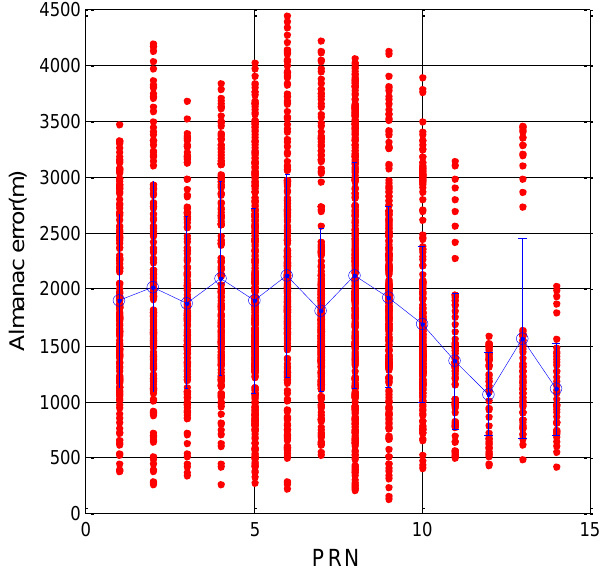
Figure 15. BDS DQA4: Satellite Position Difference between Almanac and